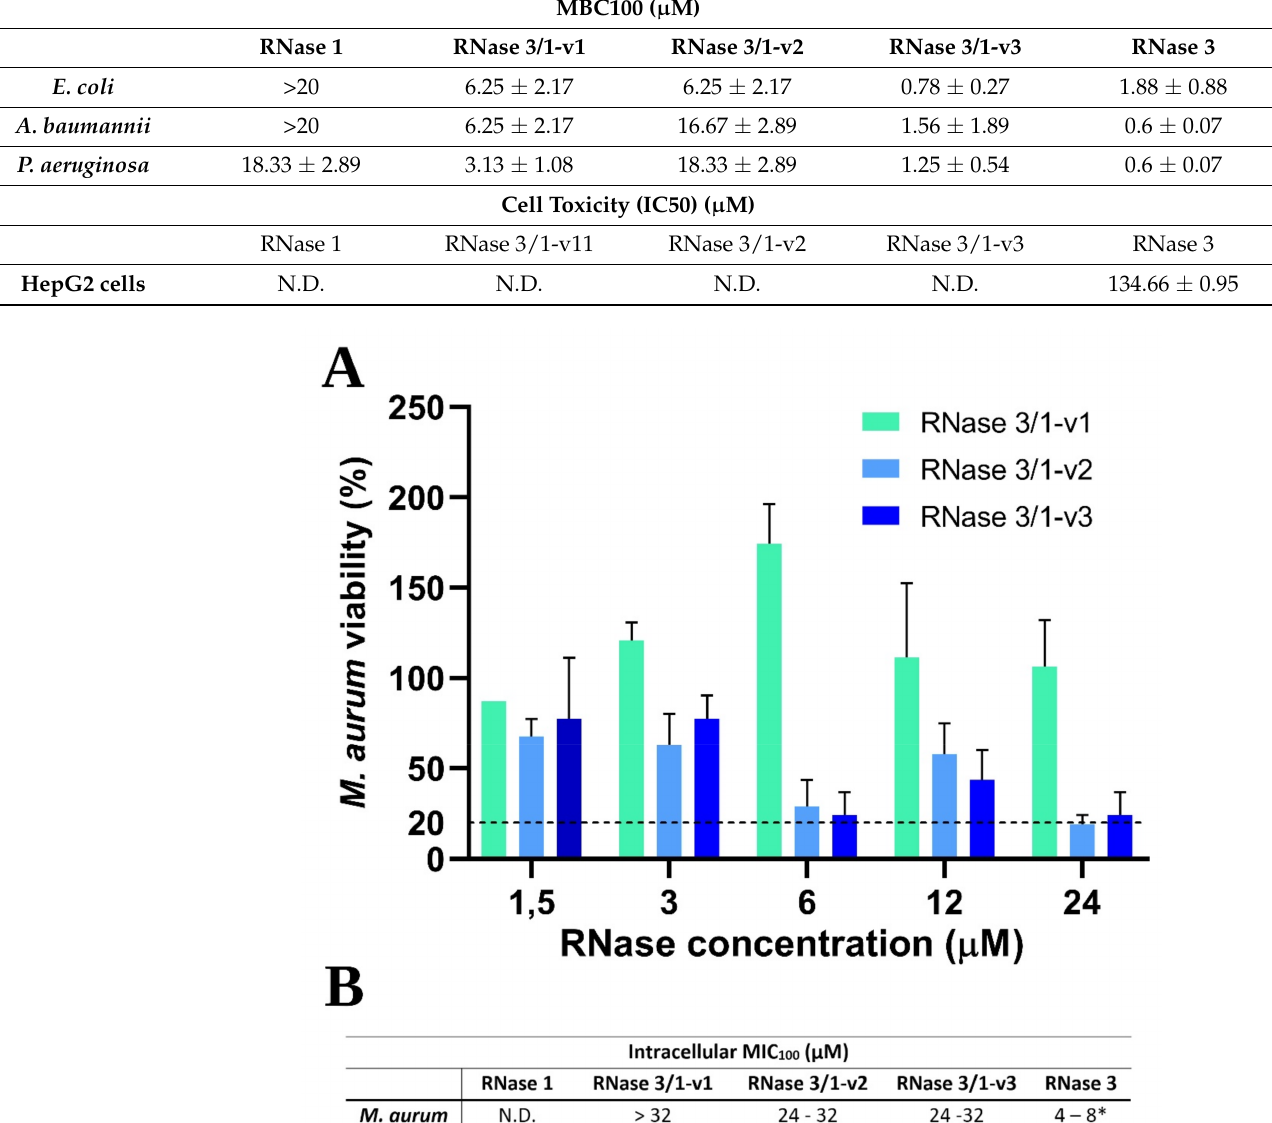
Figure 4. Intracellular Mycobacterium aurum viability in infected macrophages after 24 h of treatment with the proteins at the indicated concentrations. ( A ) M. aurum viability at each concentration of protein for the three versions of RNase 3/1. The horizontal bar shows the 20% of viability level. ( B ) The embedded table shows the intracellular MIC 100 values of the RNase 3/1 versions in comparison with its parental proteins. N.D., not detected at the assayed conditions; MIC 100 values of the three versions. * RNase 3 MIC value taken from